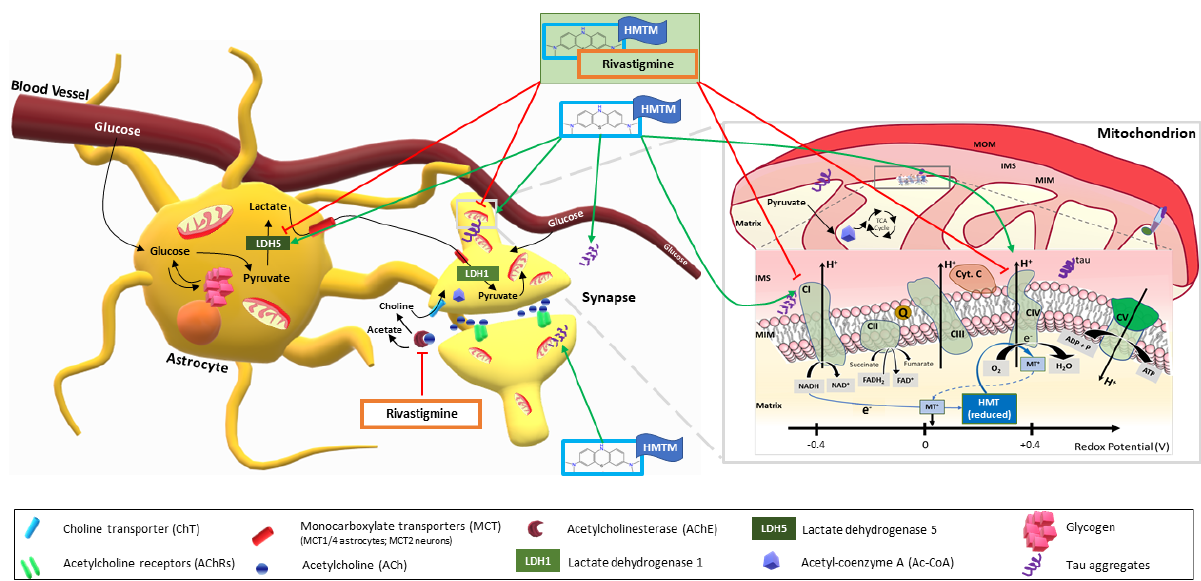
Figure 6. Proposed mechanism of action of HMTM in brain energy metabolism and interference by the acetylcholinesterase inhibitor rivastigmine. HMTM mono-dosing increases the levels of LDH-A subunits, the sole components of the astrocytic LDH5 isoenzyme responsible for converting pyruvate into L -lactate. L -Lactate is transported to the neurons via the monocarboxylate transporters, where it is converted back to pyruvate by the neuronal LDH1 (tetramer isoenzyme composed solely of LDH-B subunits). Pyruvate is the precursor for the production of acetyl-coenzyme A (Acetyl-CoA), which is the primary substrate initiating the TCA cycle in the mitochondrial matrix. The TCA cycle produces reducing equivalents in the forms of NADH and FADH 2 that are subsequently oxidised by the mitochondrial ETC, initiating the electron flow that generates the transmembrane potential that drives the production of ATP. The MT moiety in its oxidised form (MT + ) has a redox potential of 10 mV, which positions this chemical entity favourably to carry electrons directly from the reducing equivalents at the level of complex I to complex IV, therefore facilitating electron transport. MT will undergo continuous cycles of reduction and oxidation during the process of accepting and donating electrons. The pharmacological action of rivastigmine is to inhibit acetylcholinesterase, increasing the levels of acetylcholine, which clinically results in transient but limited improvement of AD symptoms. We show here that rivastigmine also prevents HMTM-induced increase in the levels of LDH-A, putatively affecting mostly astrocytic LDH5, resulting in a defective L -lactate supply to the neurons and ultimately decreasing production of ATP through oxidative phosphorylation, which mostly neurons are recognised to be mainly dependent on for highly energy-demanding process of neurotransmission. Red arrows imply inhibitory effects of the combination of HMTM and rivastigmine; green arrows represent enhancing effects of